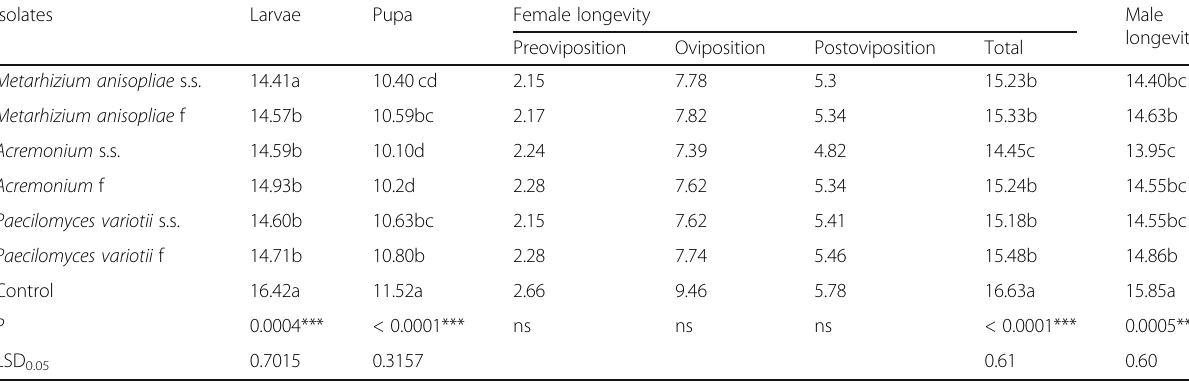
Table 2 Effect of some fungal isolates on duration in days of some developmental stages of spiny bollworm Earias insulana Isolates